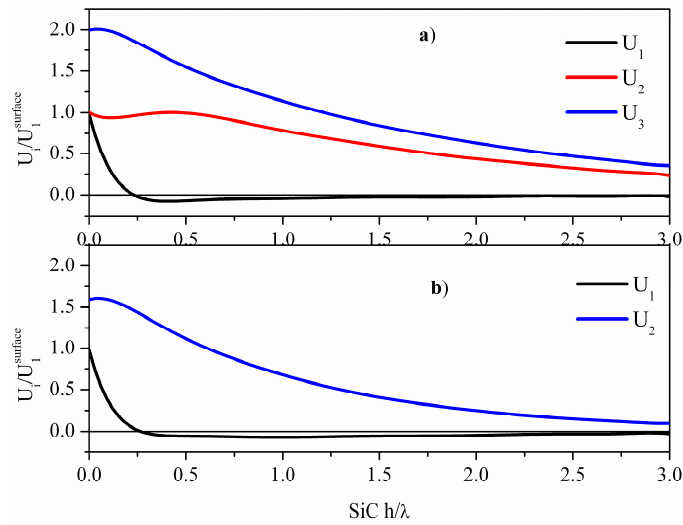
Figure 7. Variation of the normalized shear and longitudinal displacement components with depth for the SAW propagating along the <110> direction ( a ) and 30° off the <110> direction ( b ) of the (111) plane of 3C-SiC.